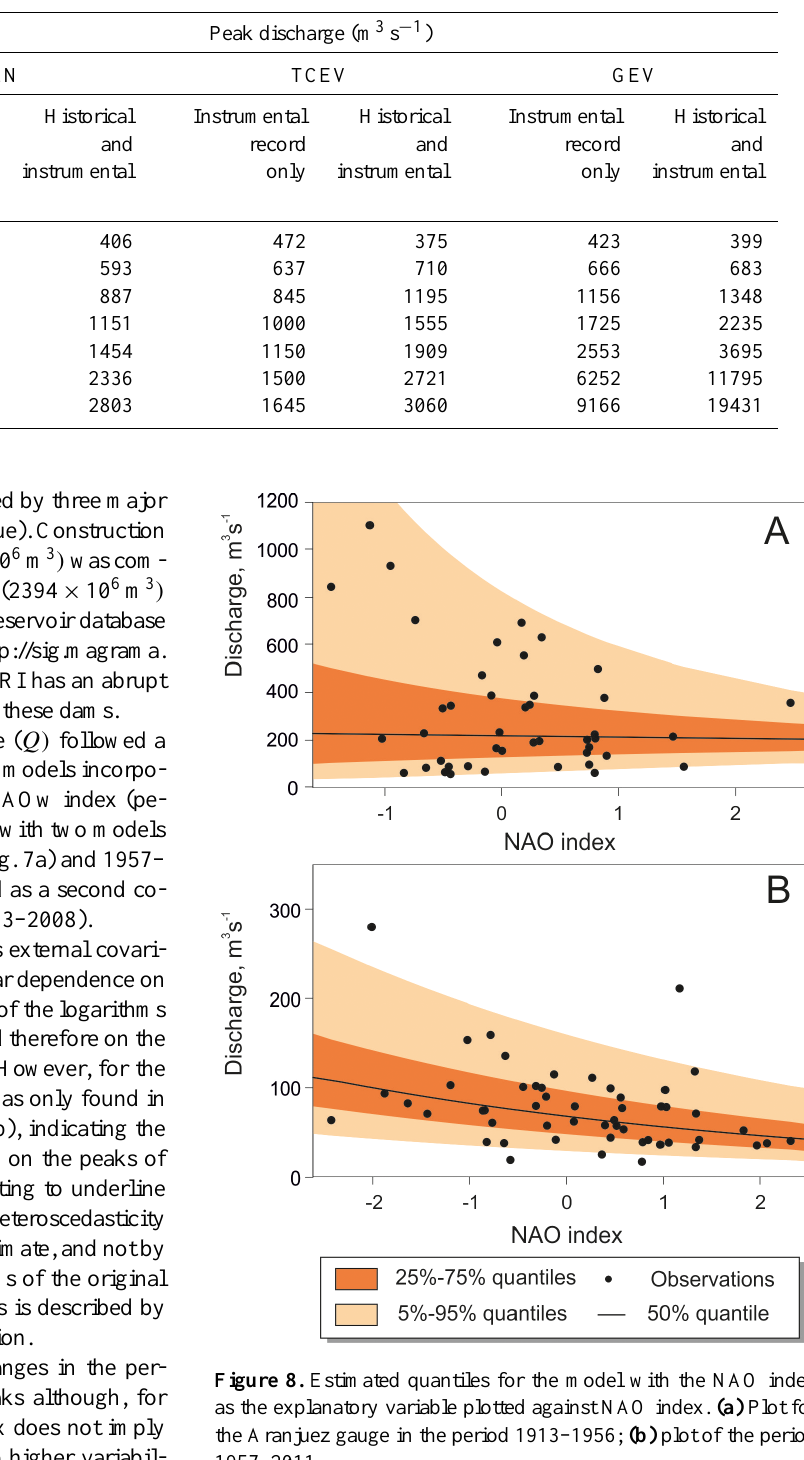
Table 1. Flood quantiles for different return periods in Aranjuez obtained using log-normal (LN), two-component extreme-value (TCEV) and generalised extreme-value (GEV) distributions fitted to firstly the annual maximum systematic records only, then the combined systematic and censored historical floods for discharges above 350m 3 s − 1 .